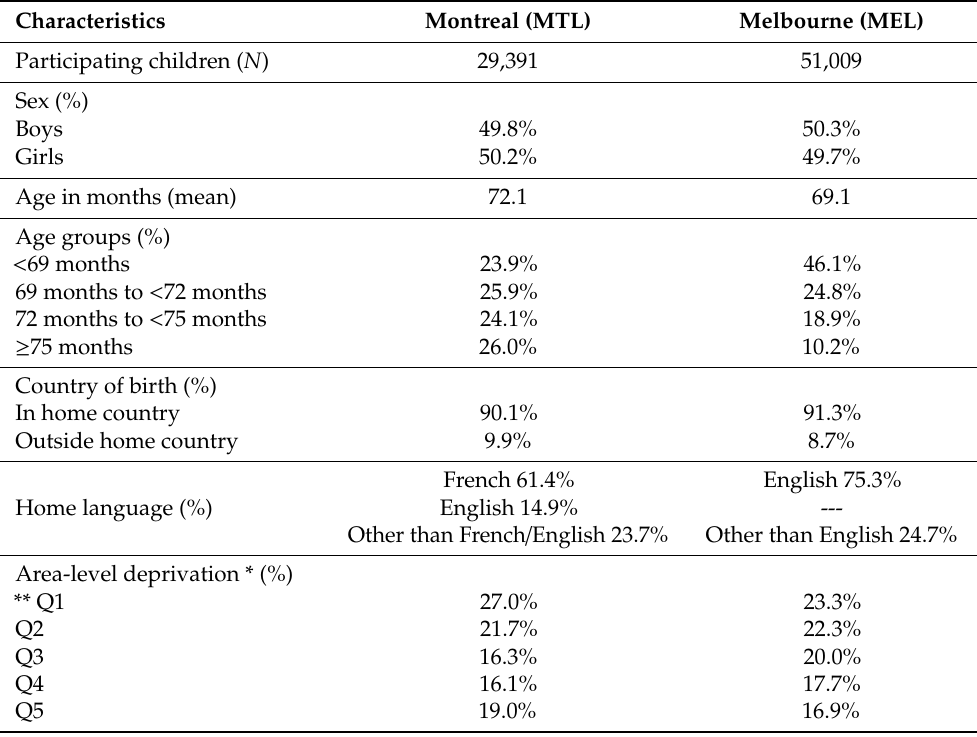
Table 3. Characteristics of the surveyed children in the metropolitan Montreal and Melbourne